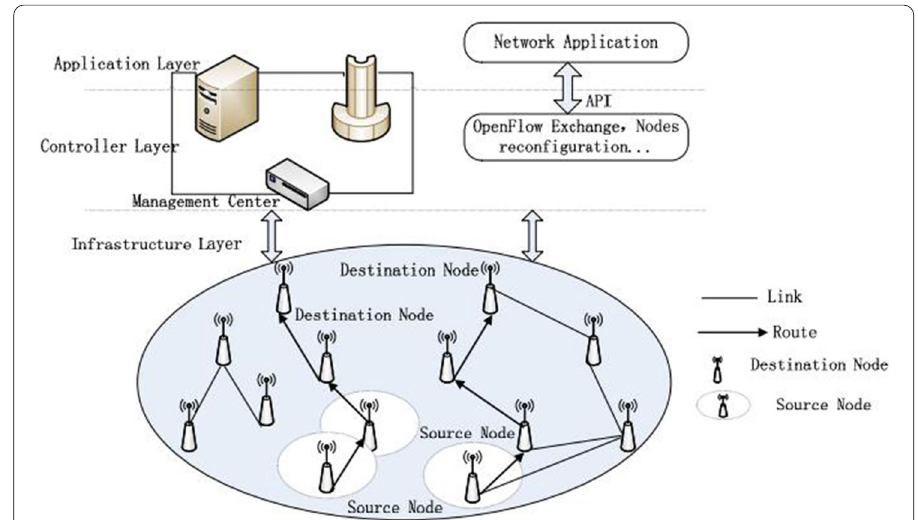
Fig. 2 The framework of